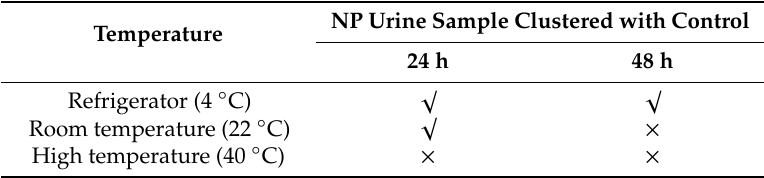
Table 2. E ff ects of temperature and duration of storage on urine